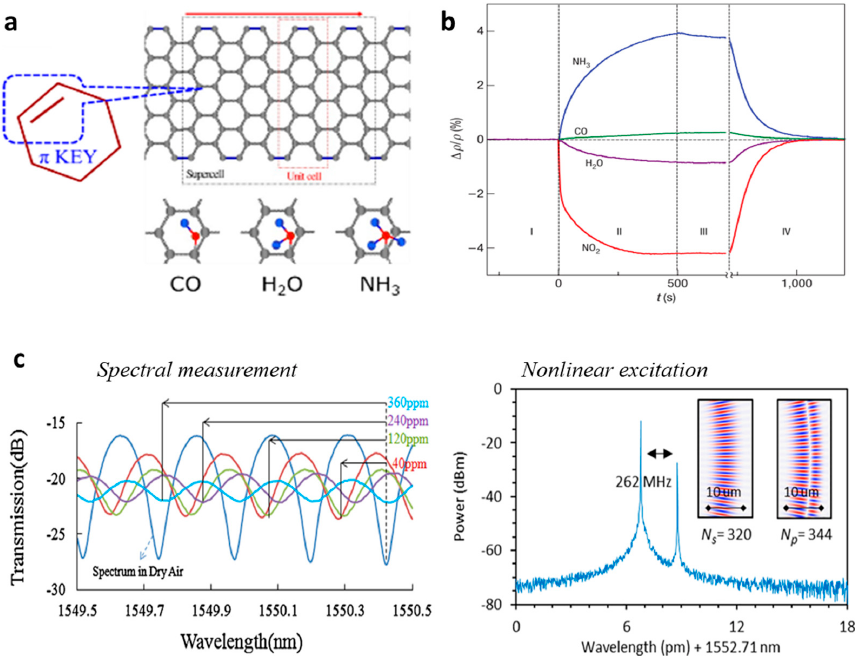
Figure 3. Mechanism of graphene-based electric and optical gas sensors. ( a ) Gas molecules adsorbed on graphene. ( b ) Detecting gas molecules adsorbed on graphene electrically. ( c ) Method to detect gas molecules adsorbed on graphene optically. Here ( a – d ) are reproduced from Refs. [30,51–53], respectively.